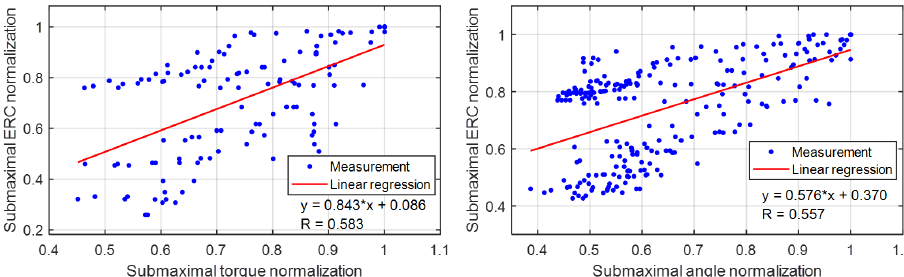
Figure 9. Summarized results of using US echogenicity as the FES-induced muscle fatigue indicator under both isometric and dynamic conditions. Reported data are from all eight